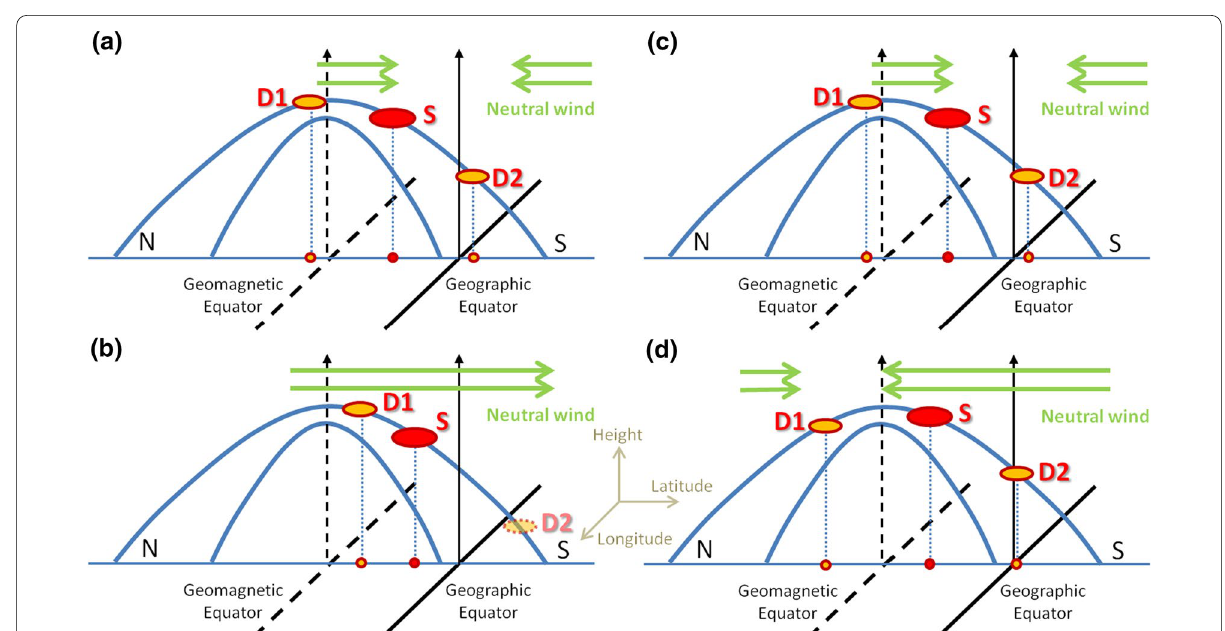
Fig. 7 Schematic diagram of single‑peaked and double‑peaked brightness behavior with neutral wind at Zone‑N in the northern a spring, b summer, c autumn, and d winter season